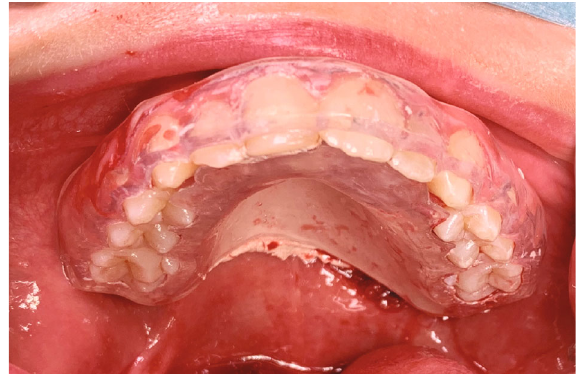
Figure 5: The wound was covered with a fabricated palatal acrylic